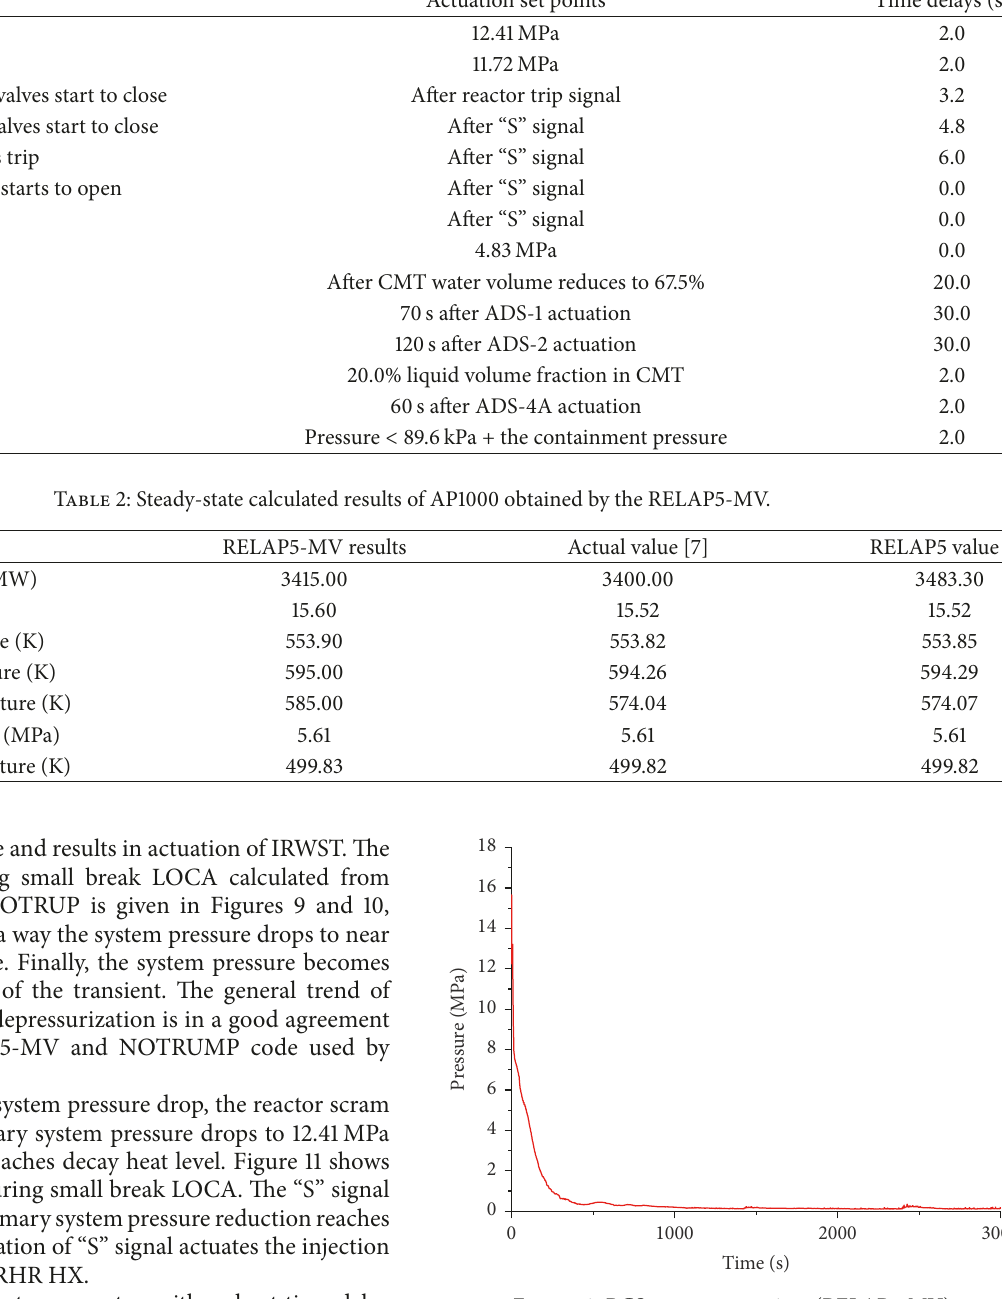
Figure 9: RCS pressure transient